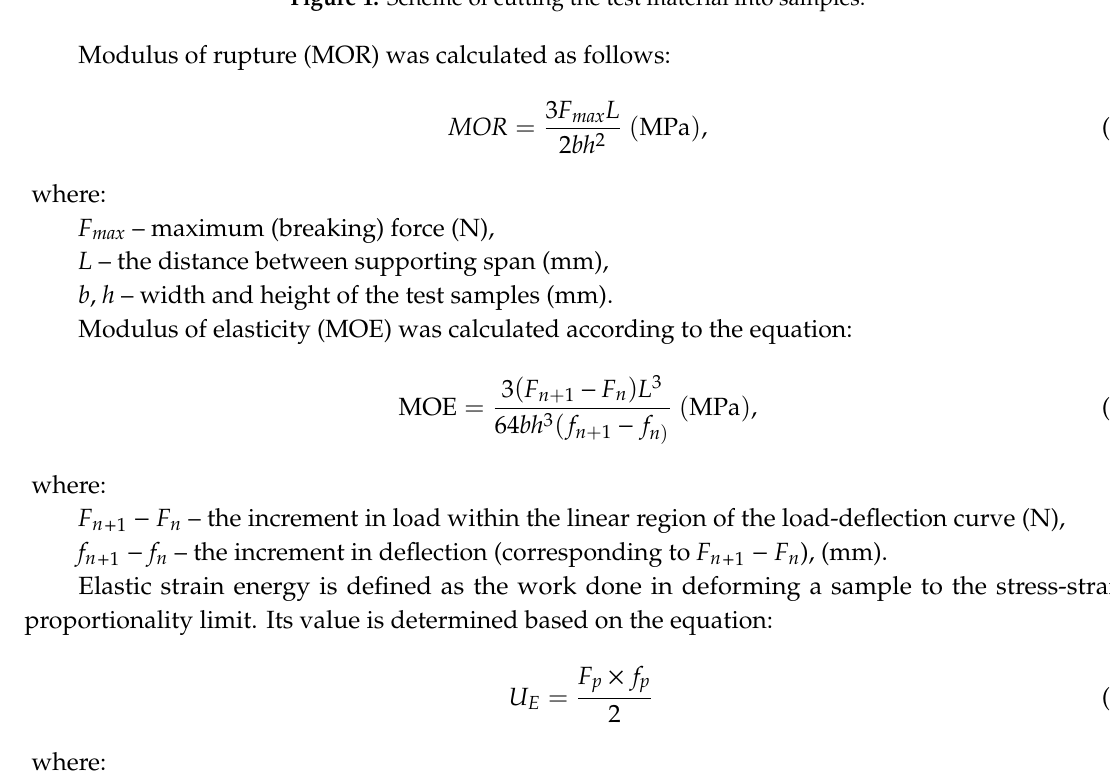
Figure 1. Scheme of cutting the test material into